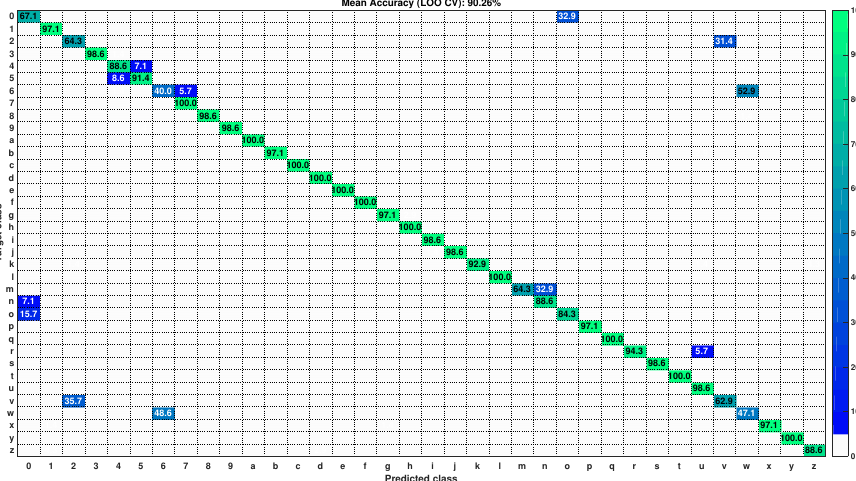
Figure 5. Confusion matrix of MU dataset with test gesture samples in LOO CV